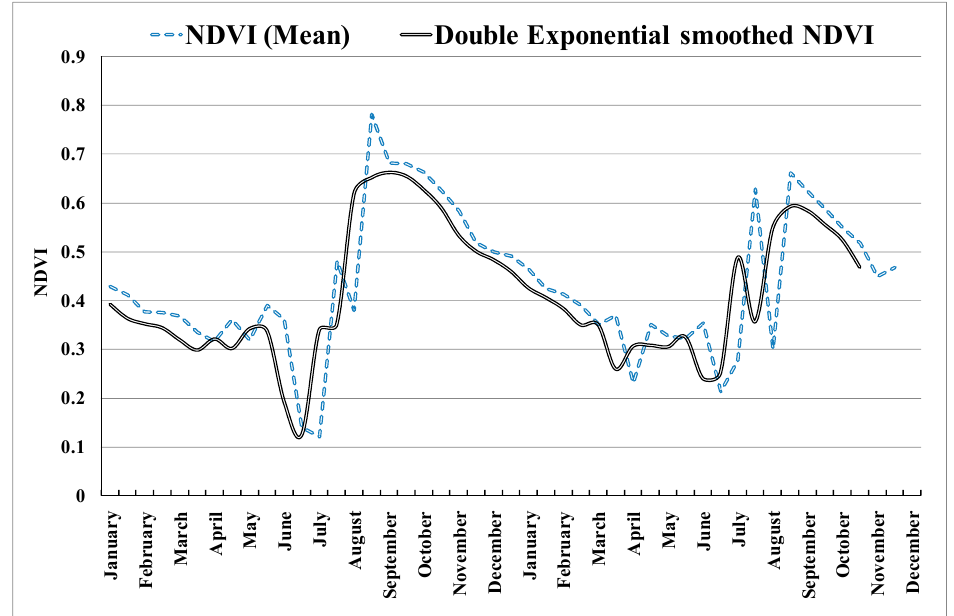
Figure 3. NDVI time series for year 2013–2014 reconstructed using double exponential smoothing. Differences in phenological patterns are notable. SOS and EOS in DDF teak were delayed by 14 and 37 days, respectively, in the year 2013–2014 (SOS date—11 August 2013; EOS date—22 March 2014) when compared to 2003–2004 (SOS date—28 July 2003; EOS date—13 February 2004). The SOS in the year 2003–2004 was observed in late July which shifted to mid-August in 2013–2014. The EOS was observed in mid-February in